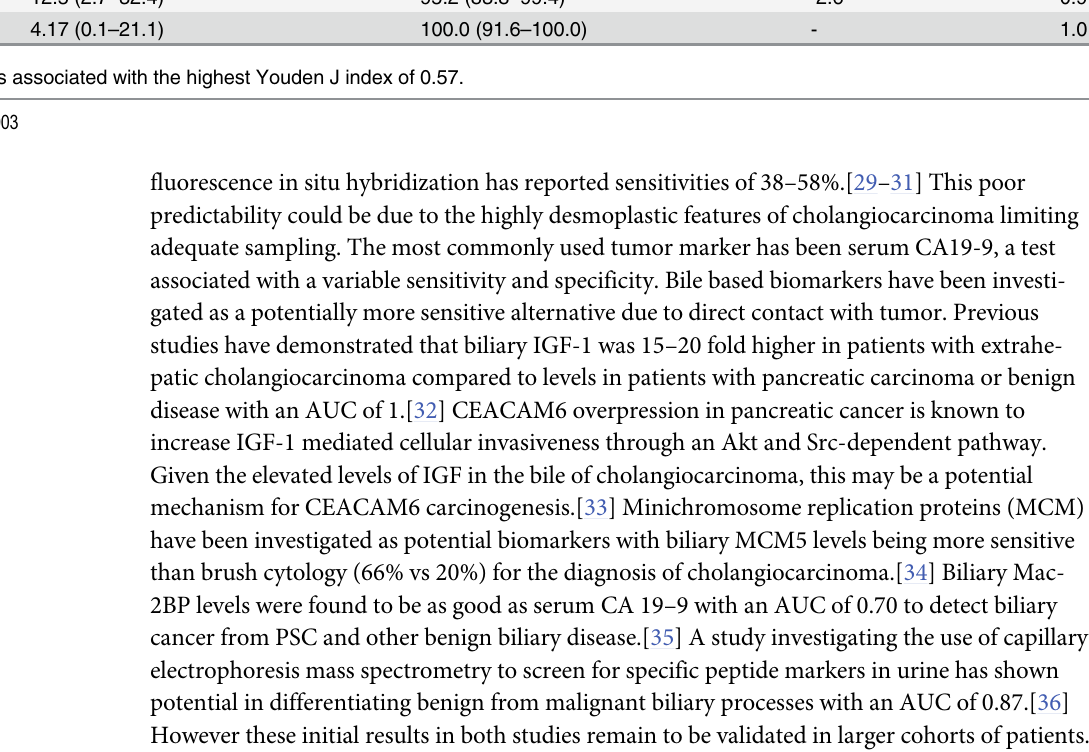
Table 4. Differences in biliary CEACAM6 levels between potentially confounding patient characteristics. Characteristic